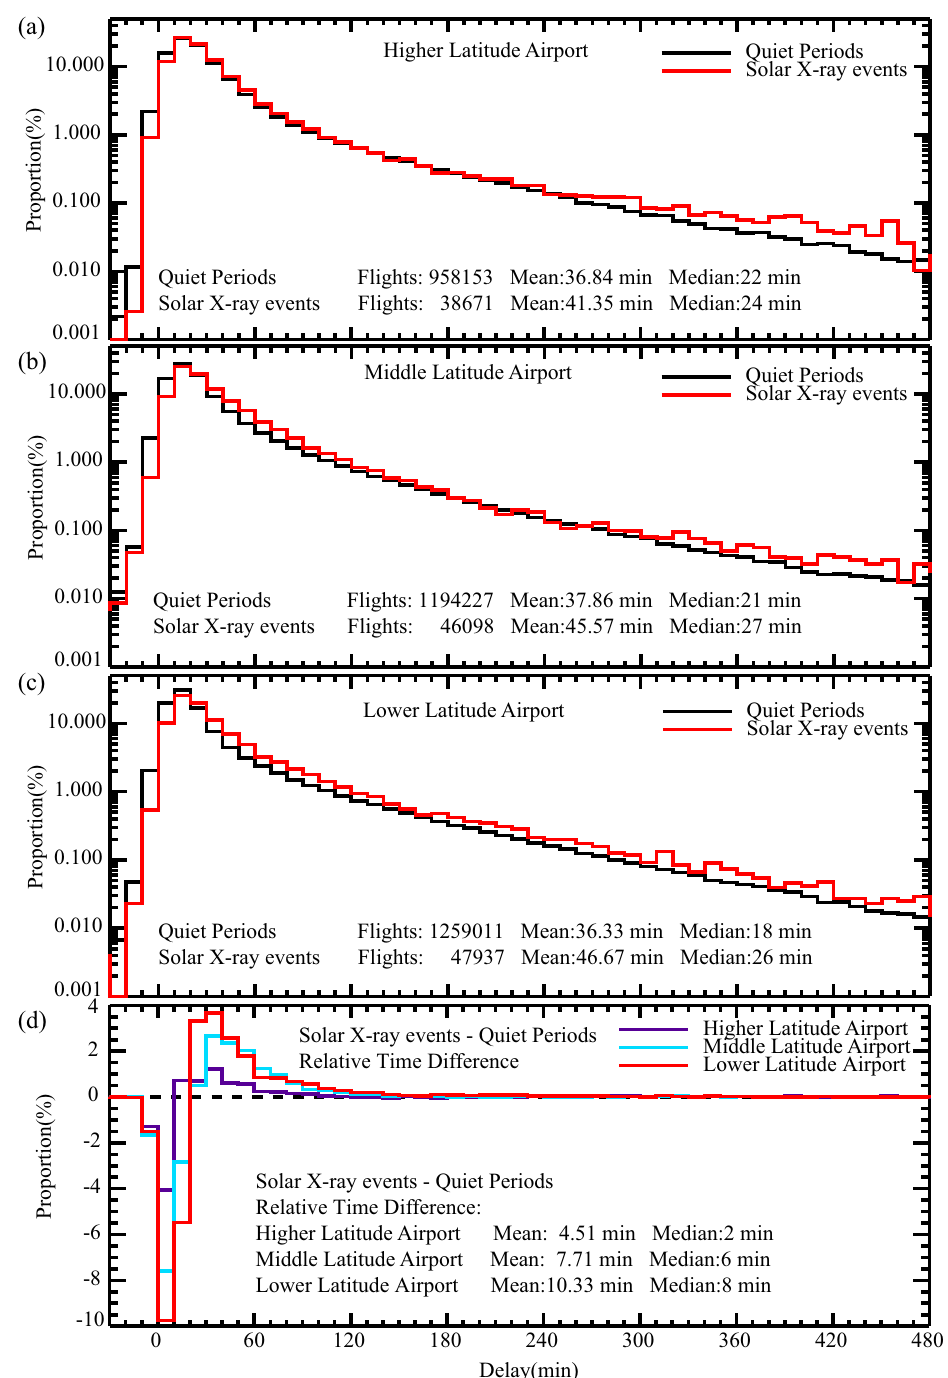
Figure 3. The PDF of flight departure delay time during solar X-ray events (red) and quiet periods (black) at higher ( a ), middle ( b ), and lower ( c ) latitude airport respectively. ( d ) Distributions of the relative difference of delay time between those during solar X-ray events and quiet periods (higher latitude airport: purple, middle latitude airport: blue, lower latitude airport: